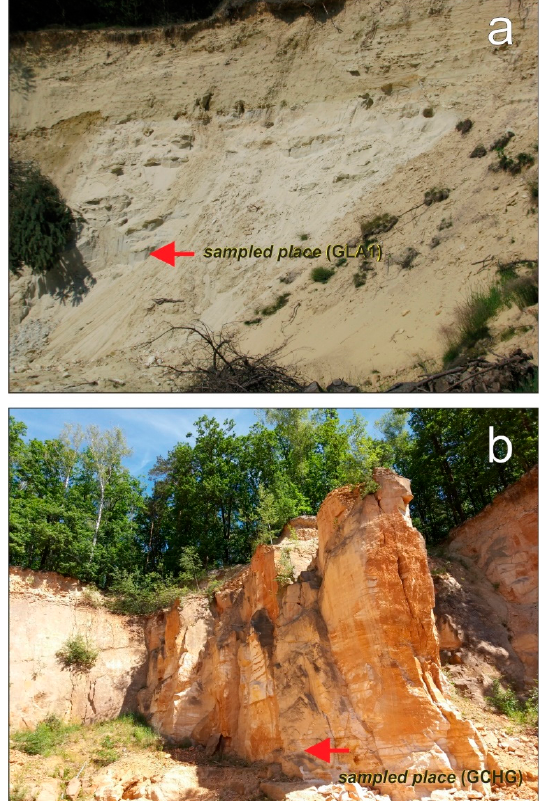
Figure 3. Outcrops of Albian clastic rocks in the Miech ó w Segment. ( a ) The wall of loose yellow and white sands in a sandpit at Glan ó w-Stroniczki, ( b ) Abandoned quarry of lithified yellow quartz sandstone on top of the Chełmo